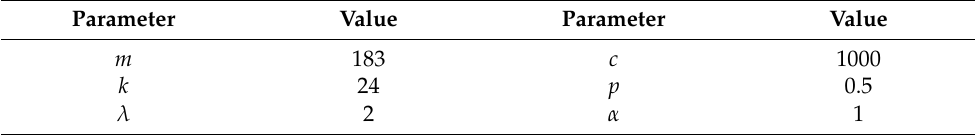
Table 2. Model parameter